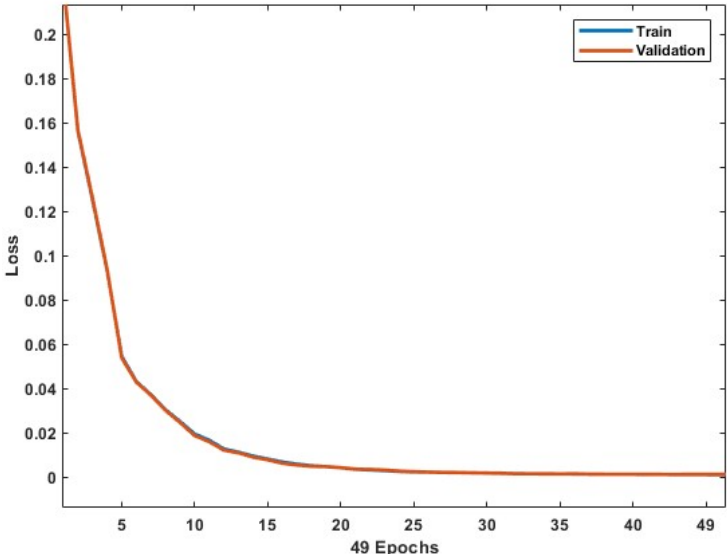
Figure 19. The training performance.